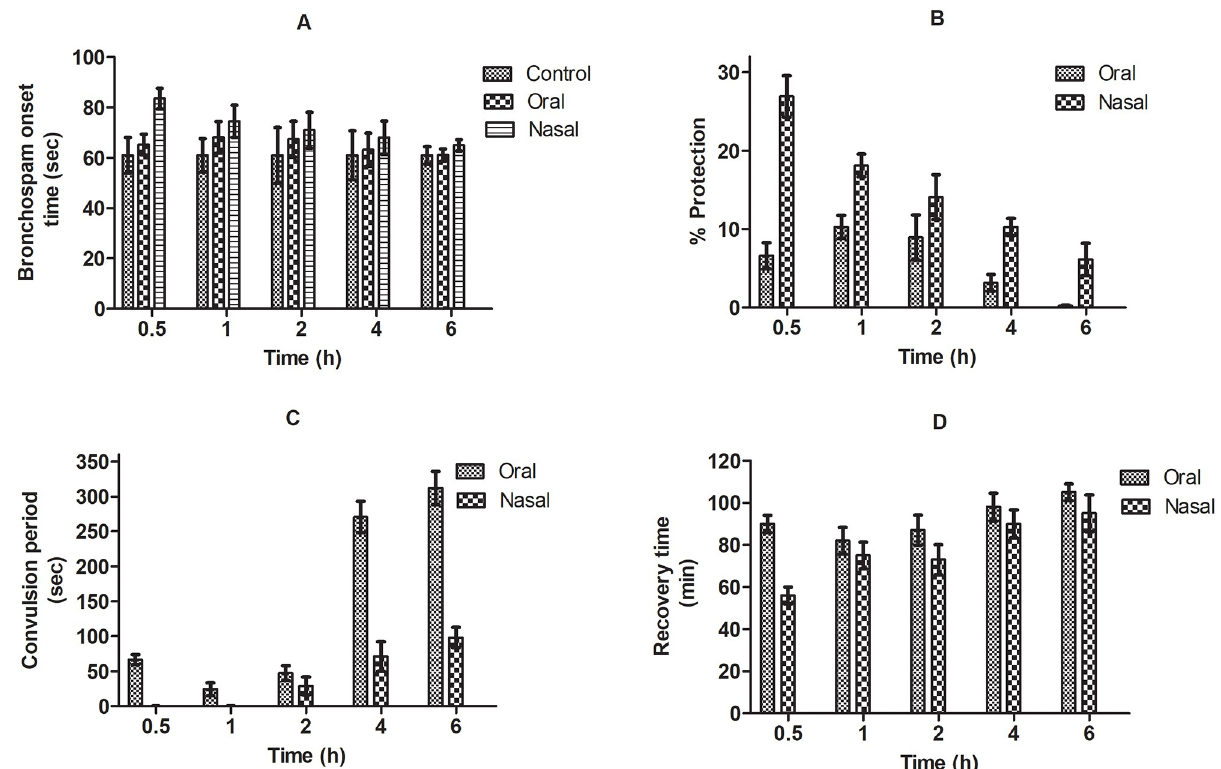
Fig 2. Effect of oral and nasal administration of bromelain on (A) bronchospasm onset time, (B) percentage protection, (C) convulsion period and (D) recovery time respectively during histamine induced acute bronchospasm.